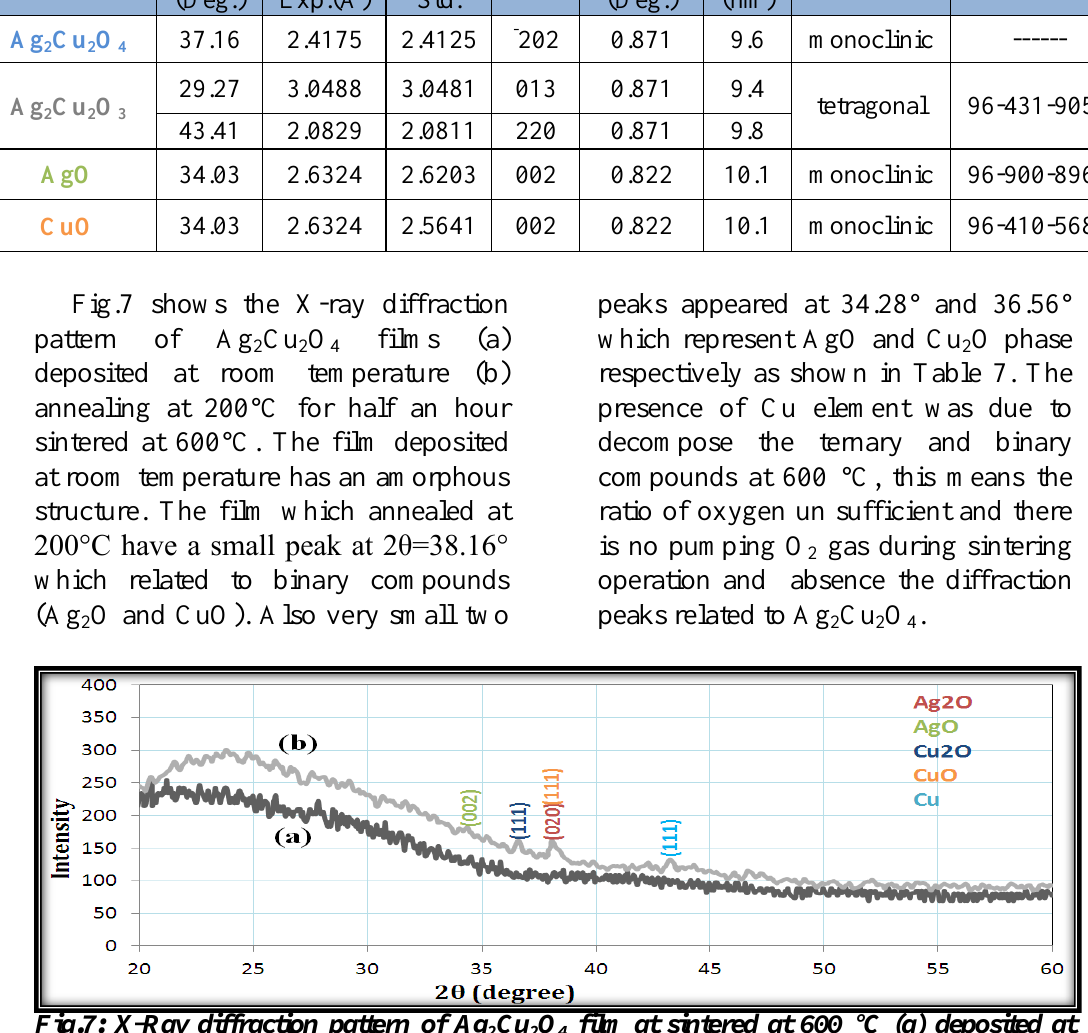
Fig.7: X-Ray diffraction pattern of Ag room temperature (b) annealing at 200 °C for half an